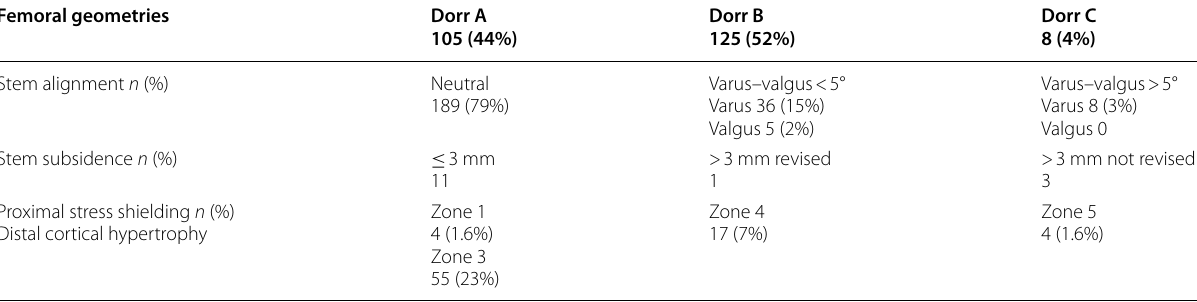
Table 4 Radiographic results at last follow-up Femoral geometries